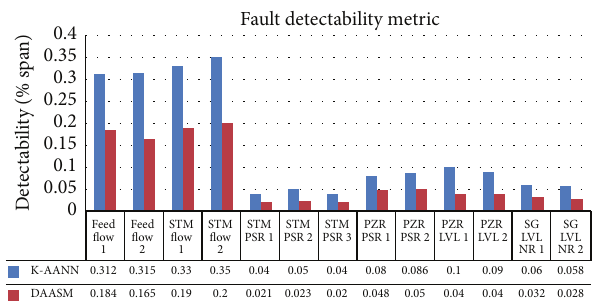
Figure 15: Comparison of fault detectability